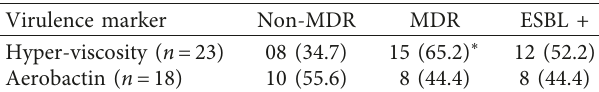
Table 7: Correlation of virulence marker with antimicrobial susceptibility patterns among Hv-Kp isolates (5 hyper-muco- viscous strains which were aerobactin gene negative were also included).